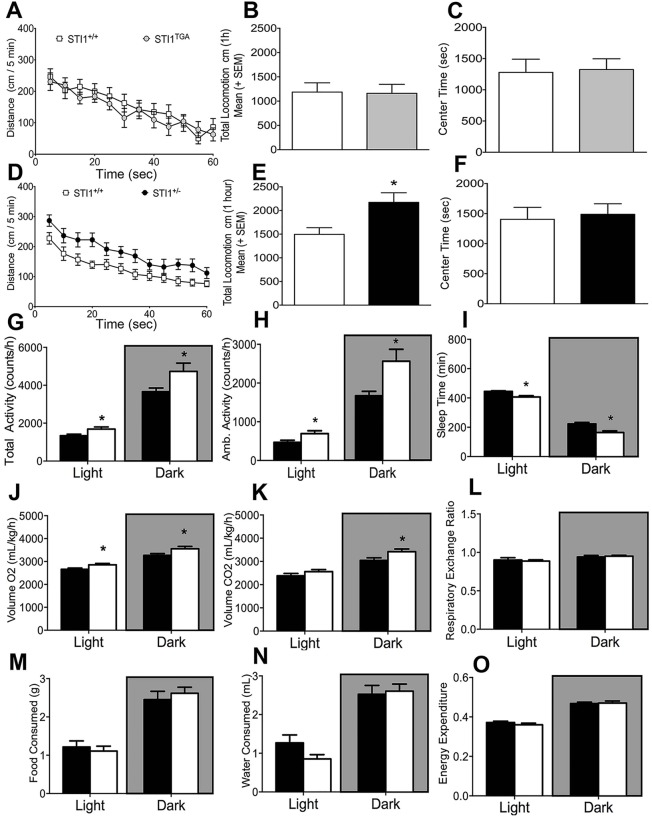
Locomotor activity in STI1TGA and STI1−/+mice and metabolic analyses in STI1−/+mice. (A) Horizontal locomotor activity in an open-field for STI1TGA (n=14) and STI+/+ control mice (n=14). (B) Cumulative 1 h locomotion for STI1TGA (n=14) and STI+/+ control mice (n=14). (C) Time spent in the center of the locomotion boxes for STI1TGA (n=14) and STI+/+ control mice (n=14). (D) Horizontal locomotor activity in an open-field for STI1−/+ (n=8) and STI+/+ control mice (n=8). (E) Cumulative 1 h locomotion for STI1−/+ (n=22) and STI+/+ control mice (n=24). (F) Time spent in the center of the locomotion boxes for STI1−/+ (n=22) and STI+/+ control mice (n=24). (G) Total activity in metabolic cages for STI1−/+ (n=8) and STI+/+ control mice (n=8). (H) Ambulatory activity in metabolic cages for STI1−/+ (n=8) and STI+/+ control mice (n=8). (I) Sleep time for STI1−/+ (n=8) and STI+/+ control mice (n=8). (J) VO2 for STI1−/+ (n=8) and STI+/+ control mice (n=8). (K) VCO2 for STI1−/+ (n=8) and STI+/+ control mice (n=8). (L) Respiratory exchange ratio for STI1−/+ (n=8) and STI+/+ control mice (n=8). (M) Food consumption for STI1−/+ (n=8) and STI+/+ control mice (n=8). (N) Water consumption for STI1−/+ (n=8) and STI+/+ control mice (n=8). (O) Energy expenditure for STI1−/+ (n=8) and STI+/+ control mice (n=8). Results are presented as means±s.e.m.; data were analyzed and compared by Student's t-test; *P<0.05 compared with control.